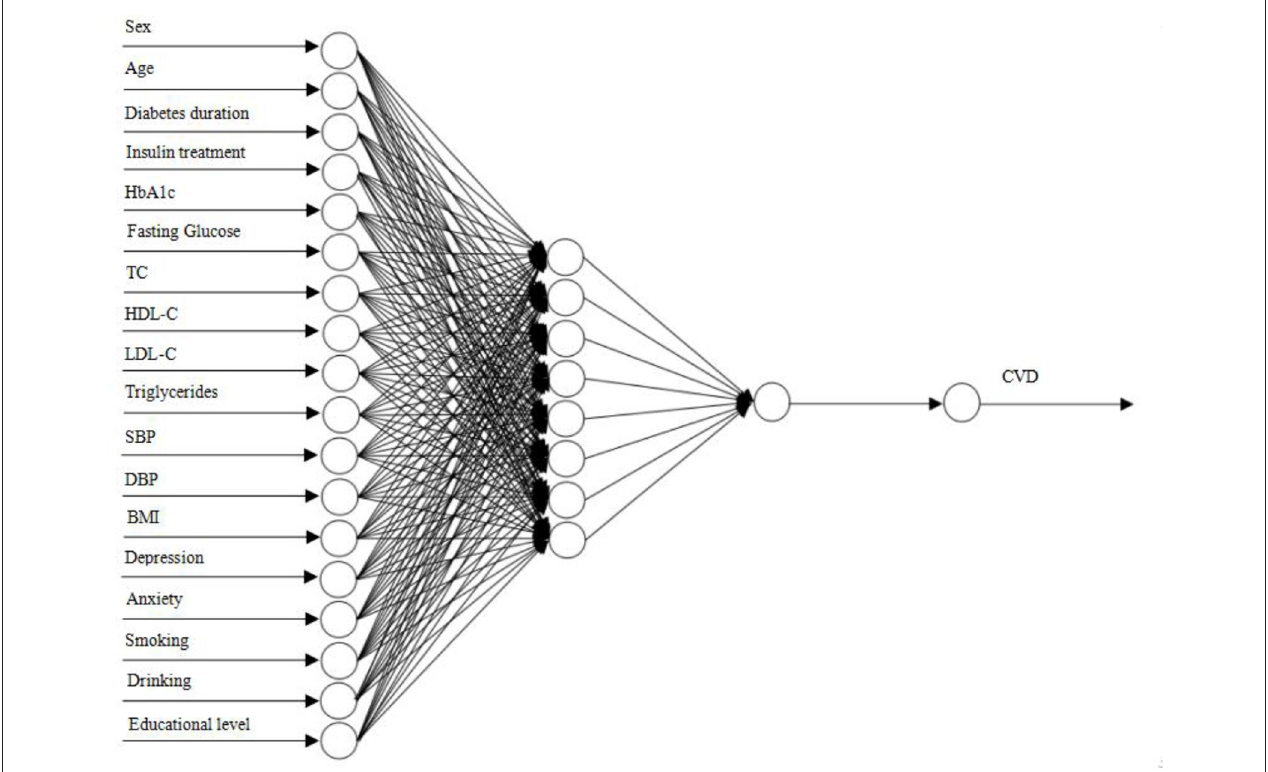
FIGURE 1 | Deep neural